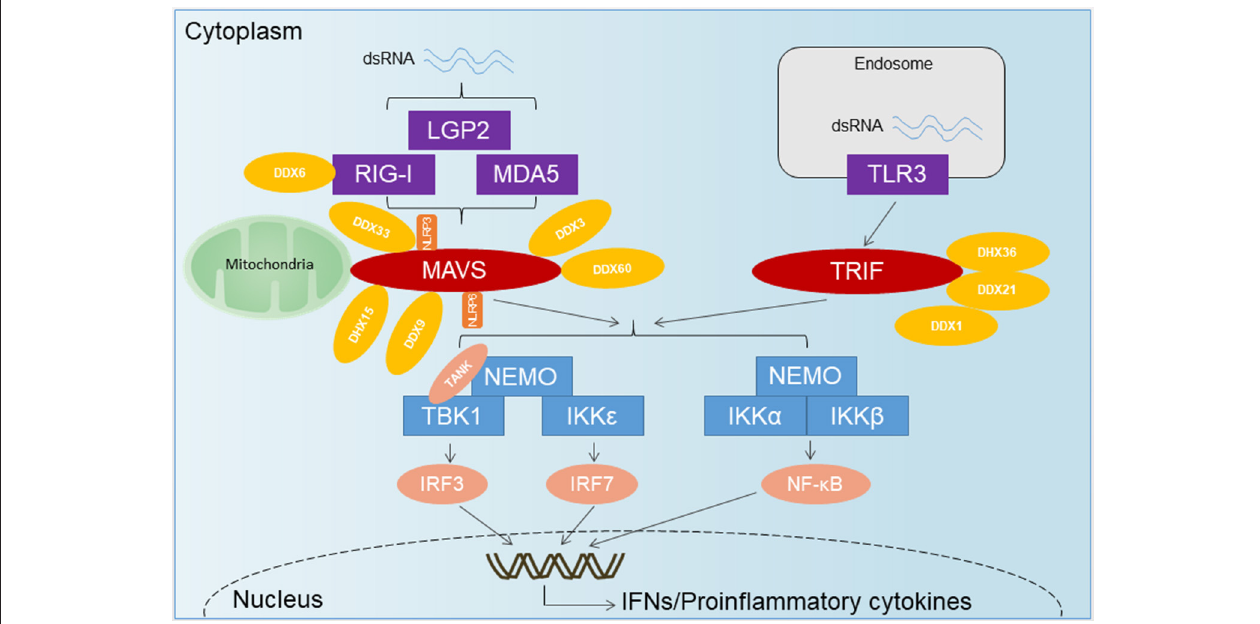
FIGURE 1 | The overview of RNA-sensing pathway. TLR3 senses dsRNA and utilizes the adaptor TRIF to activate IRF3 and NF- κ B. Upon recognition of dsRNA, RLRs are recruited by the adaptor MAVS located on the outer membrane of the mitochondria, leading to the activation of several transcription factors including IRF3, IRF7, and NF- κ B. DExD/H-Box helicases other than the RLRs and some RNA-binding proteins have emerged as important for innate immune signaling and control of virus infection. DDX1-DDX21-DHX36 forms a complex with TRIF. DDX3 has been shown to associate with RIG-I, MDA5, and MAVS. DDX60 has been shown to bind RIG-I, whereas DHX9 has been shown to interact with MAVS. DHX33 has also been shown to bind MAVS, as well as the NLR NLRP3, to induce inflammasome assembly. DHX15 may serve as a sensor for viral RNA in the cytosol to signal NLRP6-mediated interferon responses in a MAVS-dependent manner, independent of inflammasome